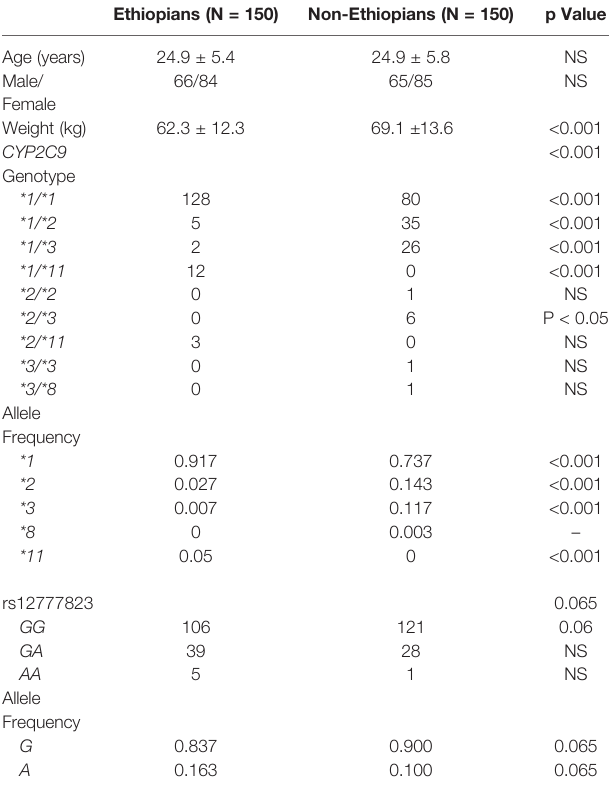
TABLE 2 | Demographic details, CYP2C9 and rs12777823 genotypes and allele frequency in Ethiopian and non-Ethiopian